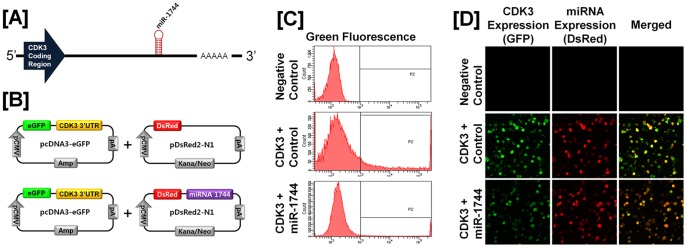

In vitro target assay for microRNAs on the CDK3 transcript.[A] Diagram of miR-1744 binding sites in the 3′-UTR of the CDK3gene. [B] Expression vector maps for eGFP within the 3′-UTR of the CDK3 gene and Ds-Red within each miRNA. The 3′-UTR of the CDK3 transcript was subcloned between the eGFP gene and the polyA tail to generate the fusion construct for the GFP transcript following the miRNA target 3′-UTR (pcDNA-eGFP-3′UTR) (upper panel) and the miRNA expression vector was designed to co-express DsRed and each miRNA (pcDNA-DsRed-miRNA) (lower panel). [C and D] After co-transfection of pcDNA-eGFP-3′UTR for the CDK3 transcript and pcDNA-DsRed-miRNA for the miR-1744, the fluorescence signals of GFP and DsRed were detected using FACS [C] and fluorescent microscopy [D]. See Materials and Methods for complete description.